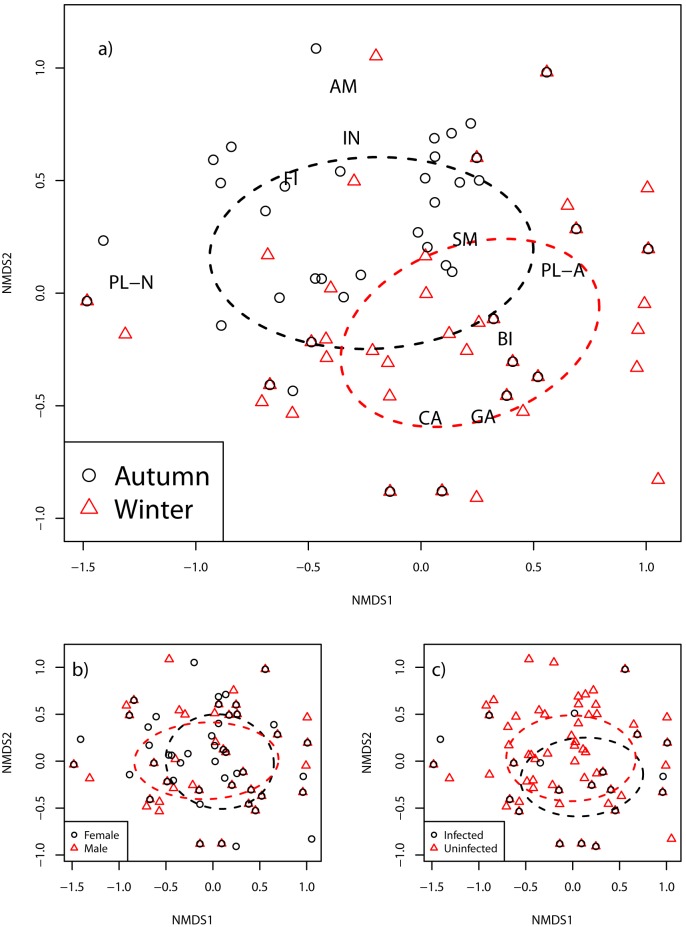
Non-metric multi-dimension scaling (NMDS; stress = 0.12) plots of raccoon dog diet between August and March in Estonia: a) samples are distinguished according to season (autumn or winter); b) the sex of the animal; or c) the mange infection status of the animal (infected or uninfected).Dashed ellipses indicate one standard deviation around the multivariate centroid of sample groups. PL-A – ‘anthropogenic plants’, PL-N – ‘natural plants’, BI – ‘birds’, SM – ‘small mammals’, CA – ‘carrion’, AM – ‘amphibians’, FI – ‘fish’, IN – ‘invertebrates’, GA – ‘garbage’.